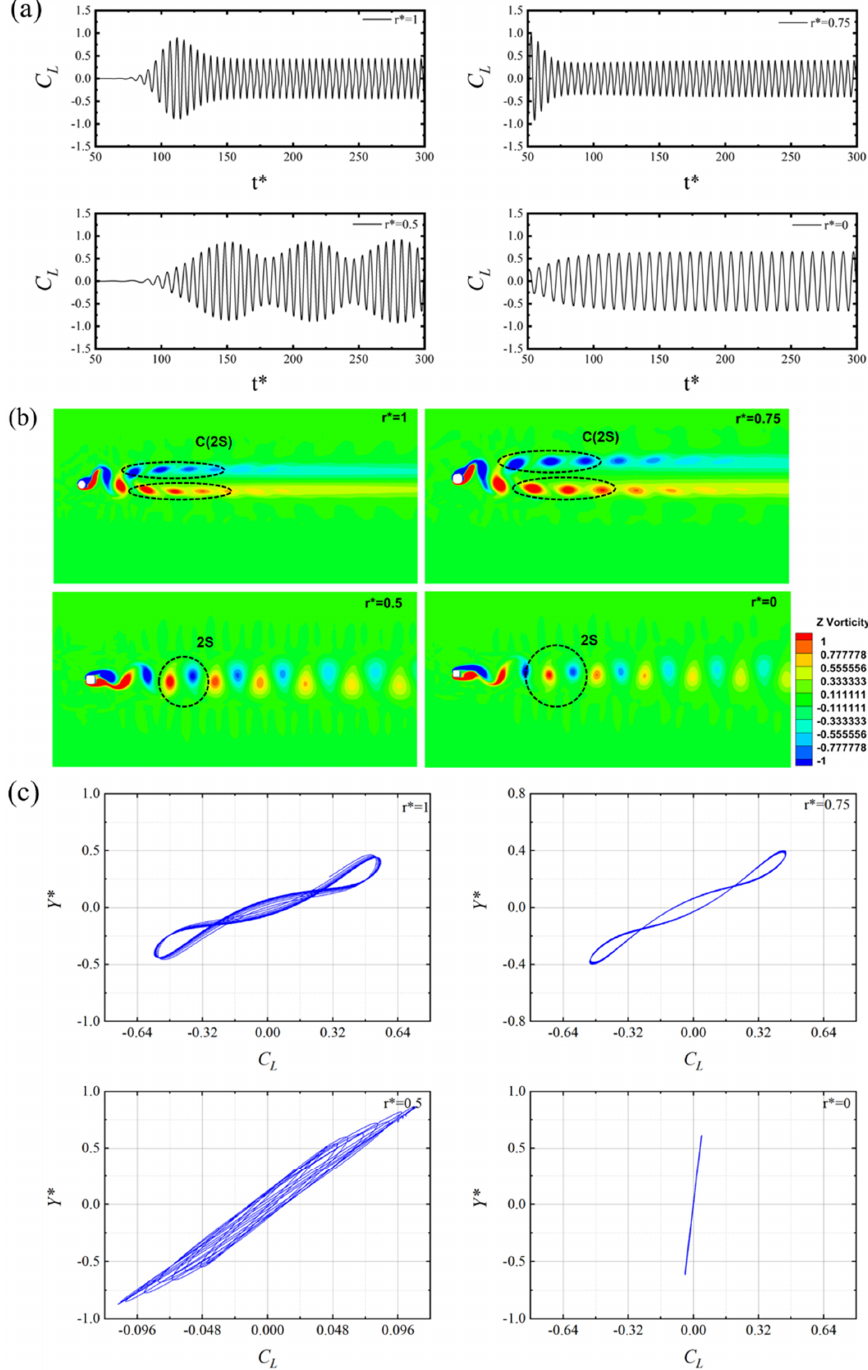
Figure 6. Effect of r* on vortex-induced vibration at Re = 150 and 𝑈𝑟 = 4.92 ( a ) Time histories of lift coefficient. ( b ) The flow field of different radius corners. ( c ) Phase diagrams illustrating the displacement vs. lift coefficient.